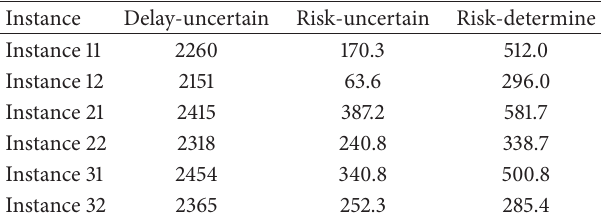
Table 2: Delay, risk in SATNFO model, and risk in deterministic model.